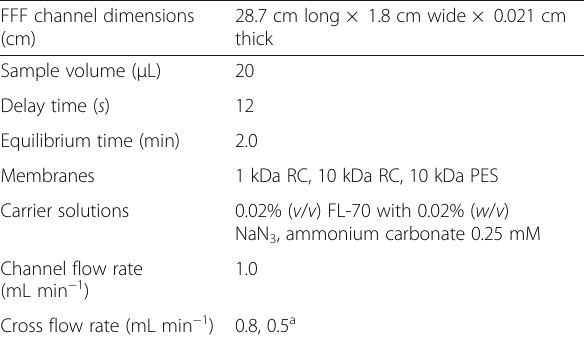
Table 1 Fl-FFF operating conditions